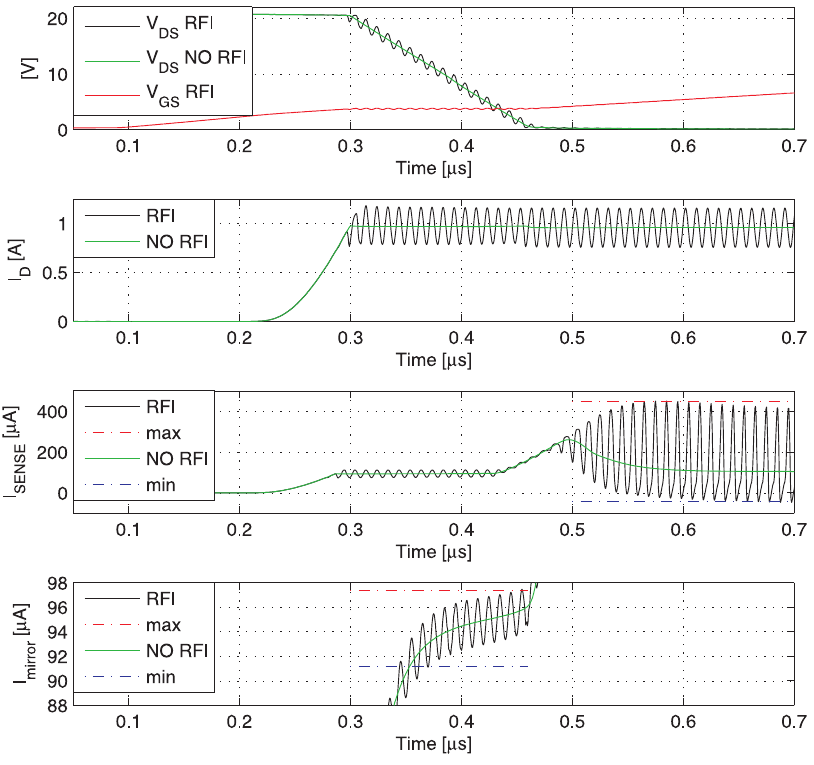
Figure 10. Maximum and minimum current-sensing of the traditional SenseFET current sensor ( I ) and the new sensor based on the Miller effect ( I SENSE sense I . CW RFI current amplitude 200 mA @ 10 D